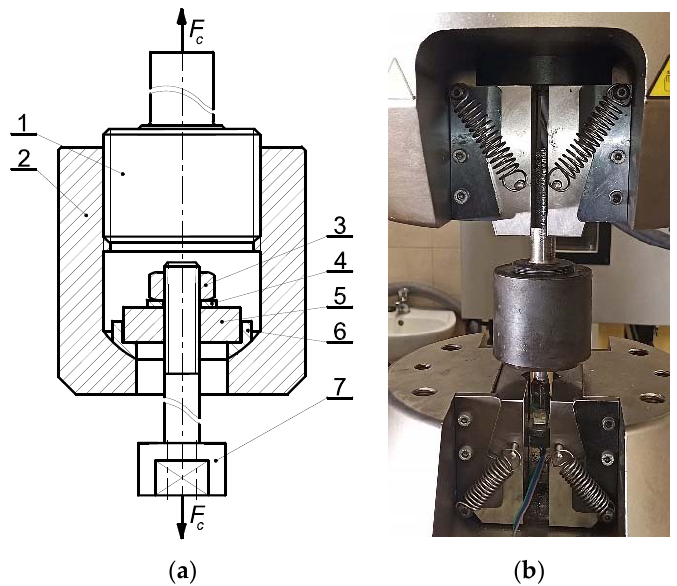
Figure 3. Equipment for calibration of the bolts: ( a ) diagram (1—special bolt, 2—handle, 3—nut, 4—washer, 5—plate, 6—spherical sleeve, 7—M10 × 1.25 bolt), ( b ) general view. Table 1. Results of the bolt calibration.